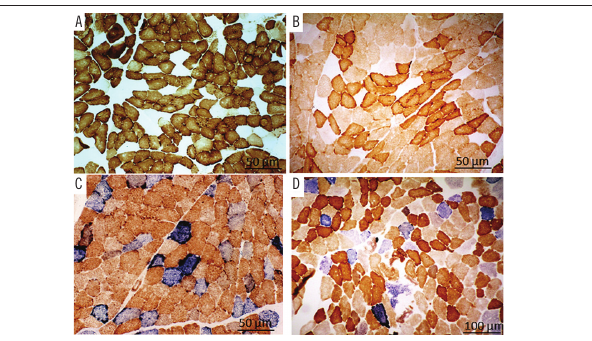
figurE 6 − COX-negative fibers (A and B) distributed in a mosaic pattern (heteroplasmy) are the most specific and frequent event found in mitochondrial disorders (mtDNA mutations). Some missing COX-deficient fibers can be found using COX plus SDH stain (COMBO) and are shown in C-D. The strong blue stain from SDH (complex II, only nDNA) overpasses COX brown stain from COX-deficient fibers (complex IV, mtDNA and nDNA). COMBO+ fibers are even more frequent in those cases COX: cytochrome c oxidase; mtDNA: mitochondrial deoxyribonucleic acid; SDH: succinate dehydrogenase; COMBO: COX staining with SDH; nDNA: nuclear deoxyribonucleic